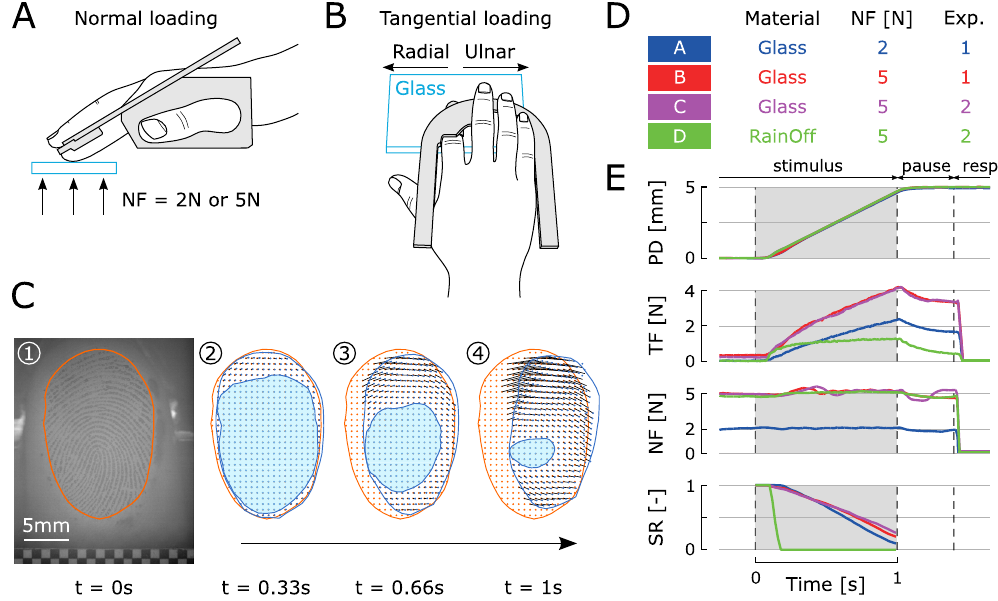
Figure 1. Apparatus, experimental conditions and typical traces. (A) The right index fingertip of the subject (side view) is kept in place with a rigid support (in grey). A glass plate (blue) is pressed vertically against it with a controlled NF of 2N or 5N. (B) The glass plate is then moved horizontally with a speed of 5 mm/s in the radial or ulnar direction before retracting from the fingertip (top view). (C . 1) Typical fingerprint image acquired with the imaging system composed of a coaxial light source and camera. The orange contour delimits the contact between the fingertip and the plate. (C . 2–C . 4) Illustration of finger pad deformation under ulnar loading at constant speed (5 mm/s) over a distance of 5 mm with NF = 2N (corresponding to blue curves in panel E). The orange contour is the initial contact area reproduced from subpanel C.1. The blue contour is the contact area imaged at different times. The no-slip area (light blue) decreases with increasing tangential loading, while the periphery of the contact area experiences slippage. Orange dots sampled regularly in the initial contact area are linked with black lines to corresponding blue dots in the contact area under loading. (D) Summary of experimental conditions. Two stimuli were used: a bare glass plate (“Glass”) and a glass plate covered with a hydrophobic solution strongly reducing the surface-skin friction (“RainOff”). (E) Typical traces from subject S01 with a total displacement of 5 mm in the ulnar direction: plate displacement (PD), tangential force (TF), normal force (NF) and stick ratio (SR). The grey window represents the time period during which the robot was receiving a tangential displacement command and fingerprint images were recorded. Subjects’ responses were collected at the end of each trial, i.e. after the plate was retracted from the finger pad. Colours correspond to experimental conditions described in panel